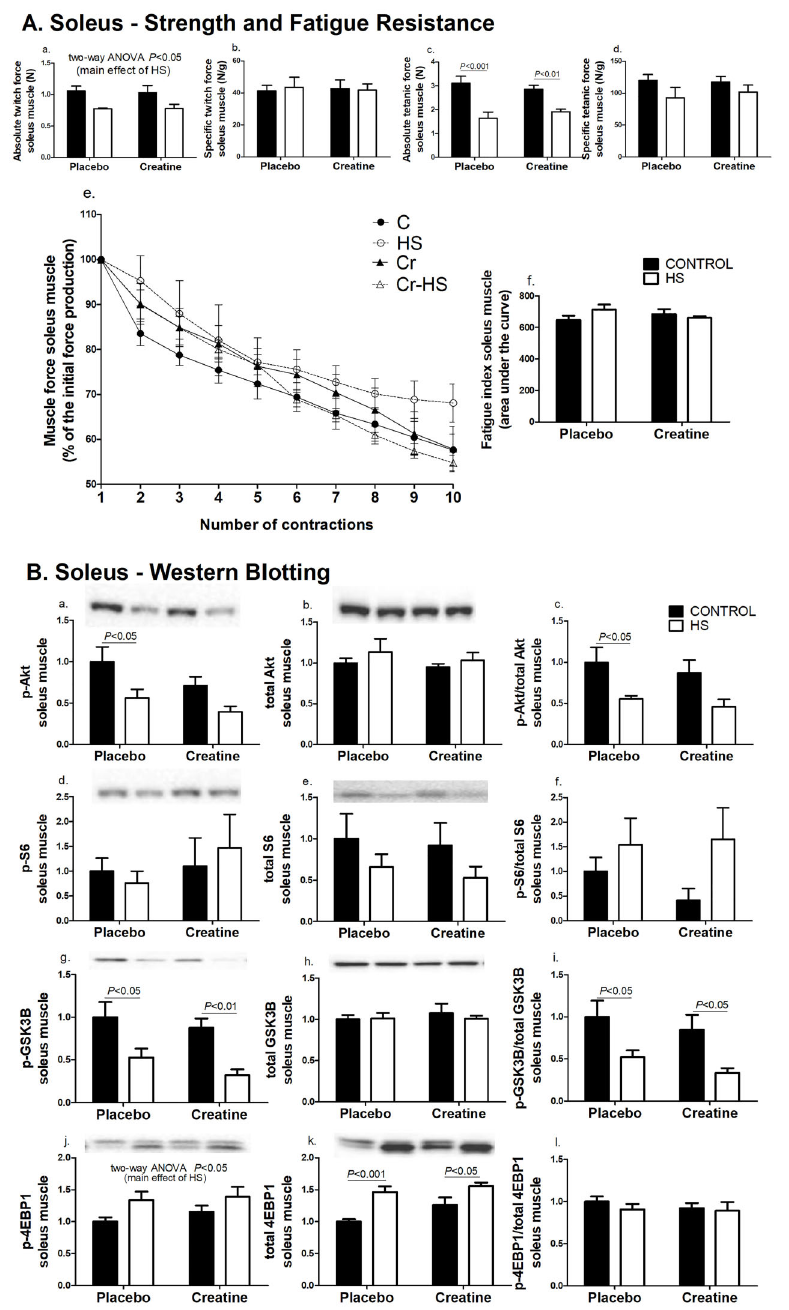
Figure 1. Strength, fatigue, and signaling pathways associated with protein synthesis in the soleus muscle. A , Parameters of strength and fatigue in the soleus muscle. The results were compared using two-way ANOVA and Bonferroni post hoc test. Aa is P o 0.05 for C and Cr groups vs C-HS and Cr-HS groups (main effect of HS), using two-way ANOVA only (no statistical differences using the Bonferroni post-hoc test). B , Markers of signaling pathways associated to protein synthesis in the soleus muscle. Data are reported as means ± SE on the basis of total protein loading as indicated by the Ponceau S measurements, n=6 – 8 animals. The results were compared using two-way ANOVA and Bonferroni post hoc test. Bj is P o 0.05 for C and Cr groups vs C-HS and Cr-HS groups (main effect of HS), using two-way ANOVA only (no statistical differences using the Bonferroni post hoc test). C: control group; HS: hindlimb suspension group; Cr: creatine supplemented group; Cr-HS: creatine supplemented and hindlimb suspension